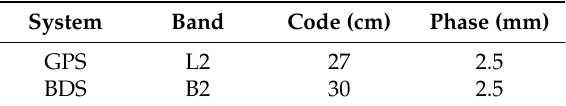
Table 1. Zenith-referenced code and phase standard